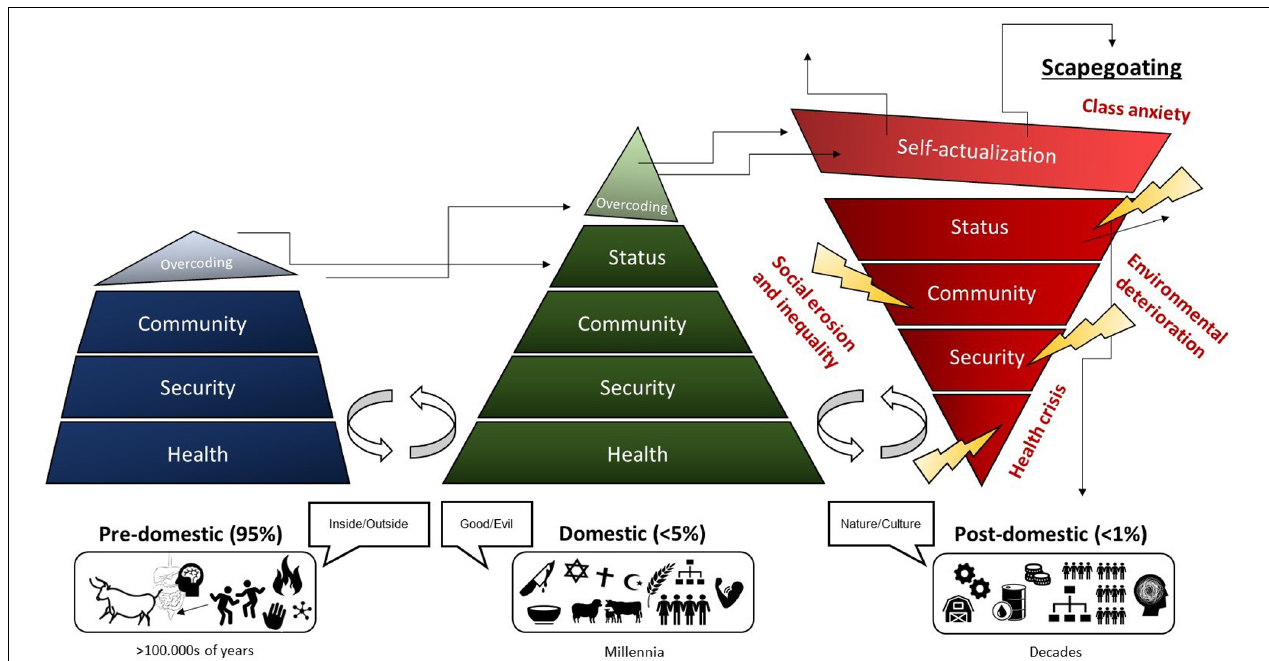
FIGURE 1 | Schematic overview of the transitioning of biosocial needs for animals in human foodscapes and thoughtscapes.